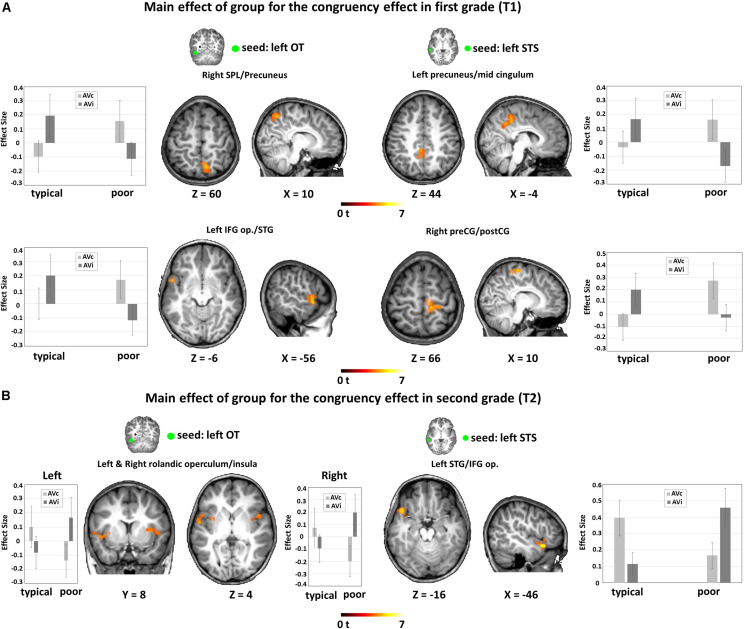
Fc-fMRI analysis: group differences within each time point. (A) Main effect of group for the congruency effect in first grade (T1). Results showed increased FC from the seed regions to frontotemporal and parietal regions for AVc pairs in poor readers and for AVi pairs in typical readers. (B) Main effect of group for the congruency effect in second grade (T2). Results showed increased FC from the seed regions to temporal regions for AVc pairs in typical readers and for AVi pairs in poor readers. Significant results are reported at a voxel-level uncorrected P < 0.001 and a cluster extent family-wise error (FWE)-corrected PFWEc < 0.05. FC, functional connectivity; OT, occipito-temporal; STS, superior temporal sulcus; SPL, superior parietal lobule; IFG op., inferior frontal gyrus pars opercularis; STG, superior temporal gyrus; preCG, precentral gyrus; postCG, postcentral gyrus.